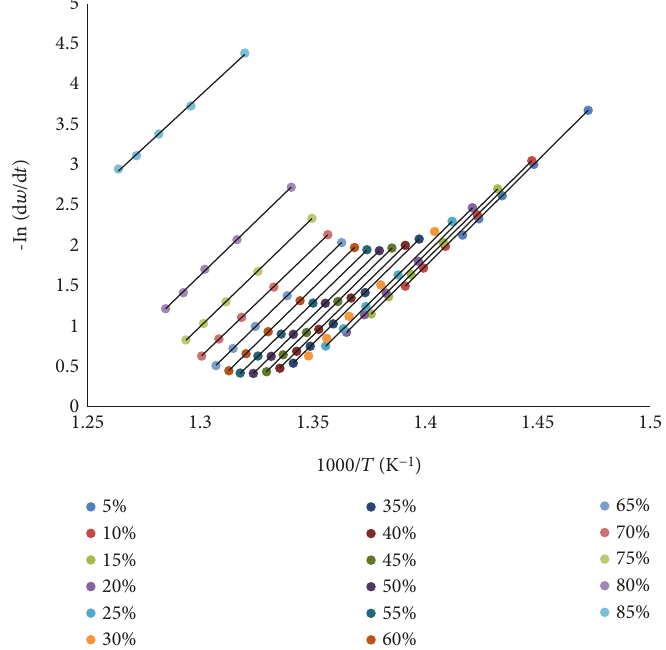
Figure 5: Determination of apparent activation energy ( E